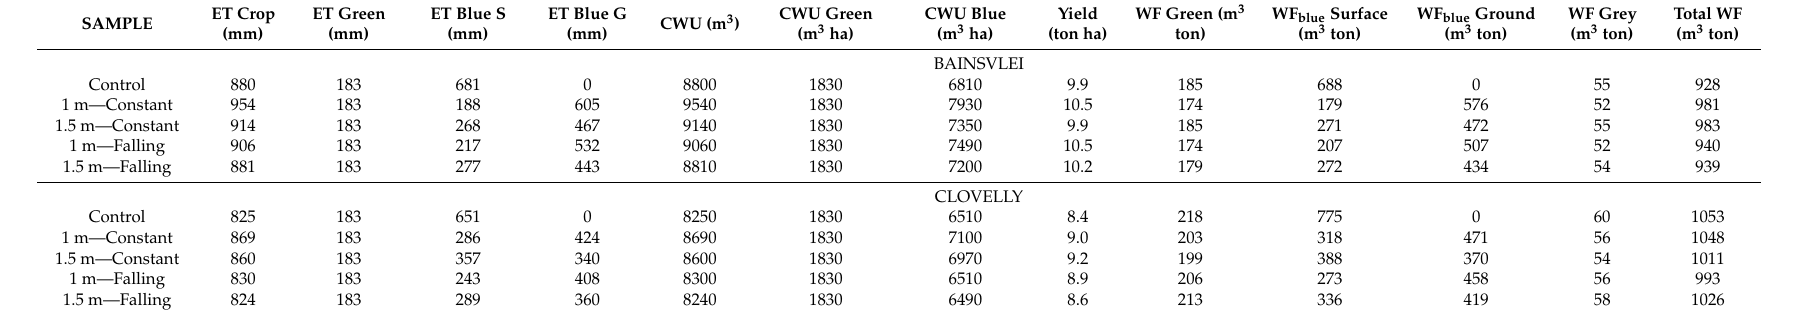
Table 3. Summary of the blue and green water footprint of wheat at the Vaalharts and Orange-Riet